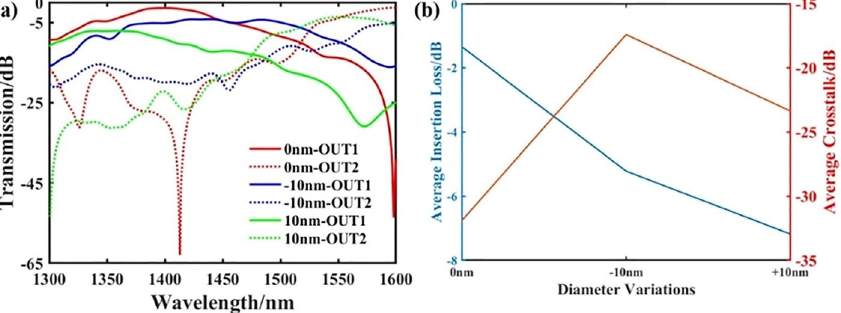
Figure 7. The transmittance spectrum under the diameter variations from − 10 to 10 nm. ( a ) The transmittance spectrum of output port 1 and port 2. ( b ) The average insertion loss and crosstalk of the two target channels under the diameter variations from − 10 to 10